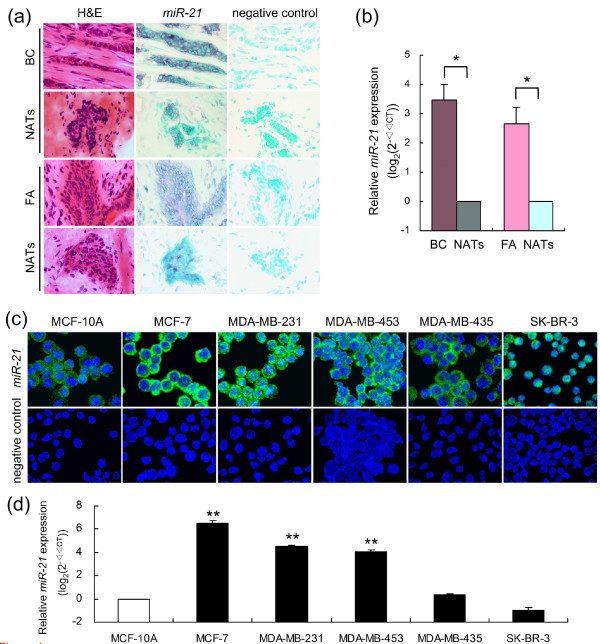
Altered expression of miR-21 in different breast tumor types and breast cell lines. (a) CISH detection using miR-21 LNA detection probe (blue) or scramble-miR as negative control were performed on consecutive 8 μM cryo-sections obtained from BC/FA tissues and corresponding NATs. DNA was counterstained with methyl green (green, × 400 magnification). (b) Total RNA was used to quantify miR-21 expression by relative qRT-PCR, normalizing on U6 RNA levels. The graph shows a log2-scale RQ calculated by normalizing the miR-21 expression values in the tumors on those in the NATs. Data indicate the mean (+SD) of four independent samples. * P < 0.05. (c) FISH detection of miR-21 in five BC cell lines (MCF-7, MDA-MB-231, MDA-MB-453, MDA-MB-435, SK-BR-3) and one non-tumorigenic epithelial cell line (MCF-10A). Positive in situ hybridization signals are visualized in green, while blue depicts DAPI nuclear stain (× 1,000 magnification). (d) qRT-PCR analysis show that MCF-7, MDA-MB-231 and MDA-MB-453 cells express higher levels of miR-21 compared with MCF-10A cells. Data are mean (+SD) of three replicates. ** P < 0.01; BC, breast cancer; FA, fibroadenoma; NATs, normal adjacent tissues.